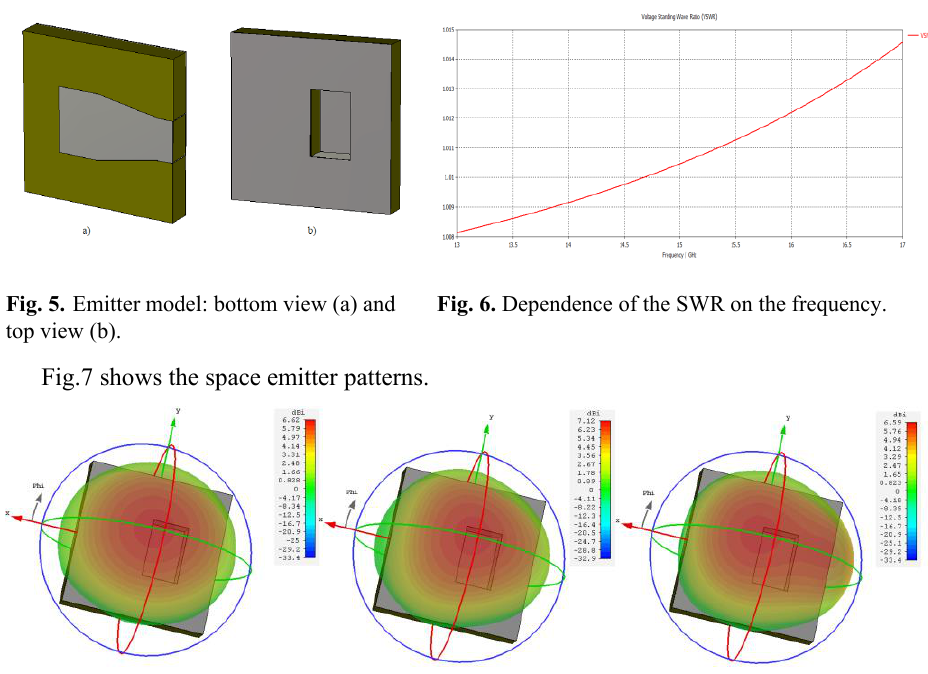
Fig. 7. Space patterns of printed